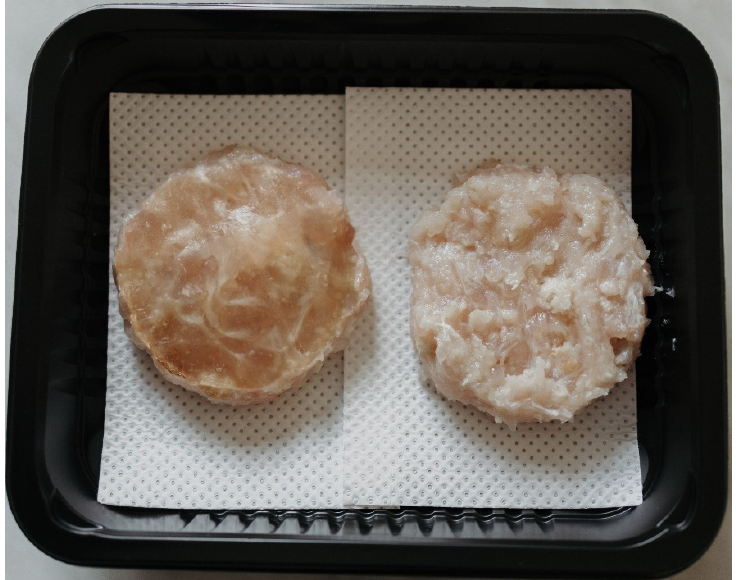
Figure 3. Active packaging (left side, fish burger covered with biopolymer film based on whey pro- tein isolate with tarragon essential oil) versus conventional packaging (right side, uncovered fish burger).